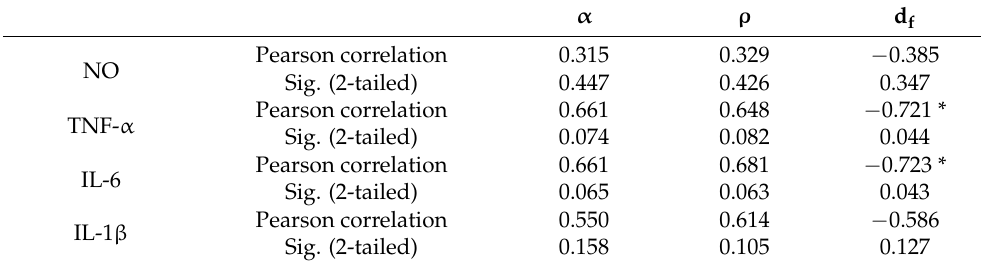
Table 3. Pearson correlation analysis between chain conformation parameters and immunoreactivity